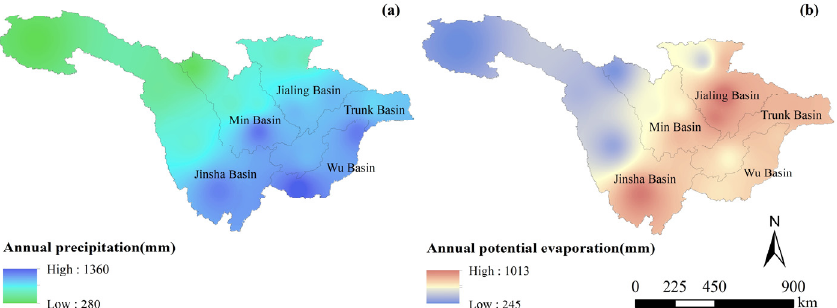
Figure 8. ( a ) Spatial distribution of multi-year average precipitation in the upper reaches of the Yangtze River from 1956 to 2020. ( b ) Spatial distribution of multi-year average potential evaporation in the upper reaches of the Yangtze River from 1956 to 2020.